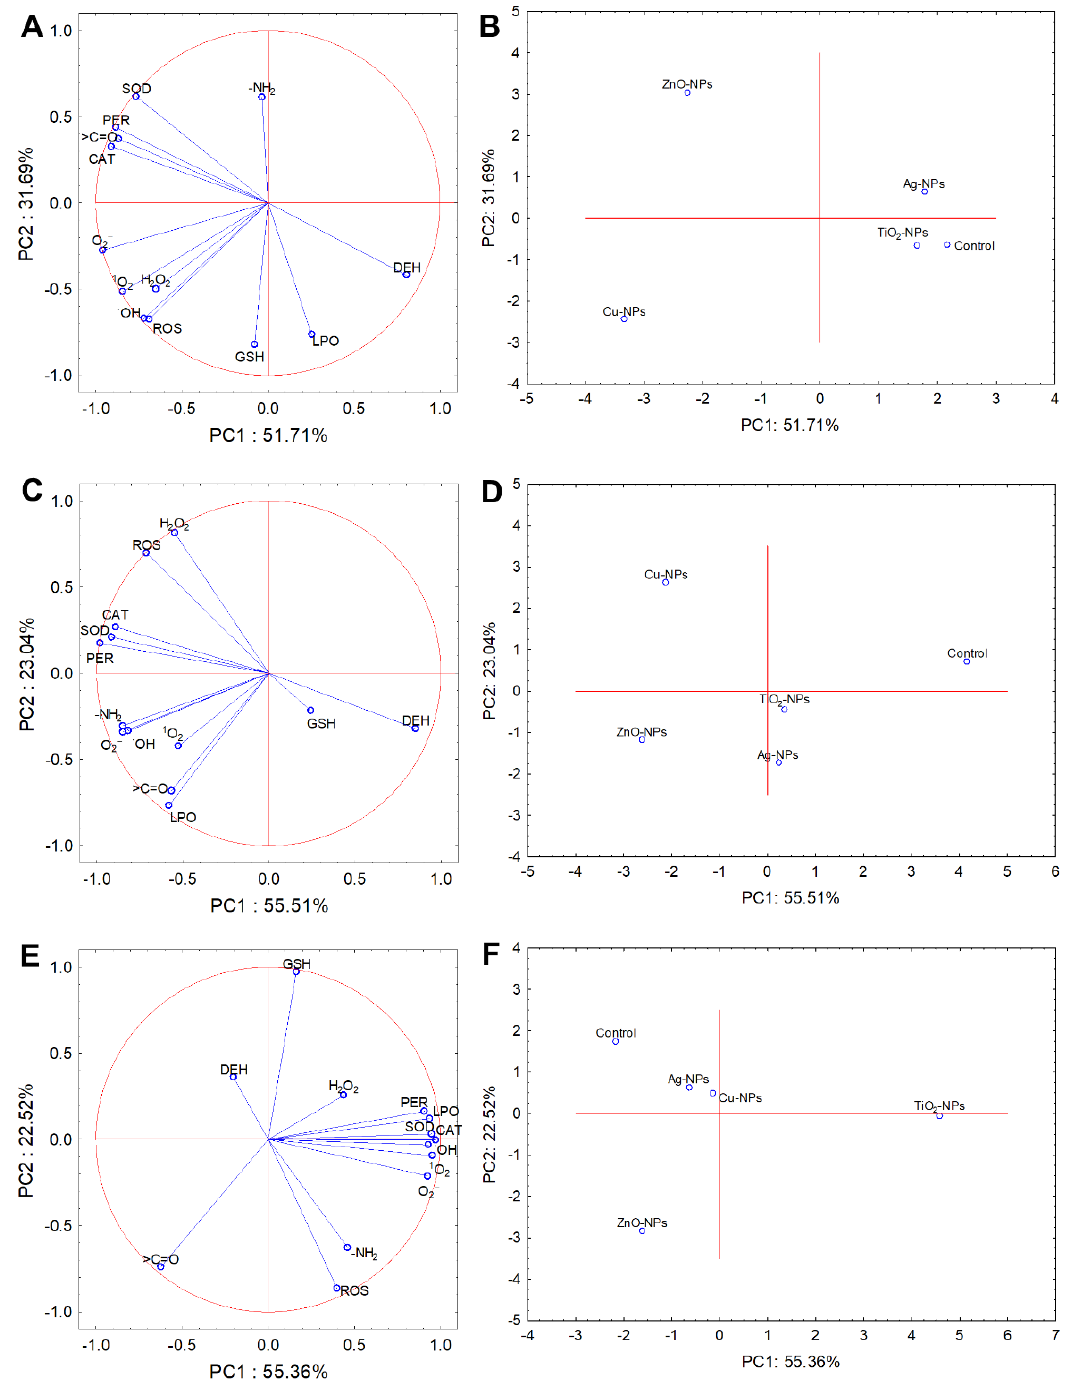
Figure 6. Projection of the individual plot and PCA analysis of free radicals (H 2 O 2 , • OH, 1 O 2 , O 2 •− ), ROS, GSH, LPO, content of >C=O and -NH 2 , and enzymes activity (CAT, PER, SOD, DEH) along PC1 and PC2 for the control and NPs-treated cells of E. coli ( A , B ), B. cereus ( C , D ) and S. epidermidis ( E , F ).